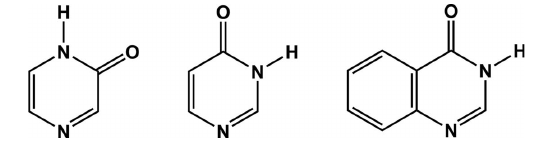
Figure 2 (Left) 2(1 H )-pyrazinone, 2-pyz , (middle) 4(3 H )-pyrimidinone, 4-pym , and (right) 4(3 H )-quinazolinone, 4-quz .